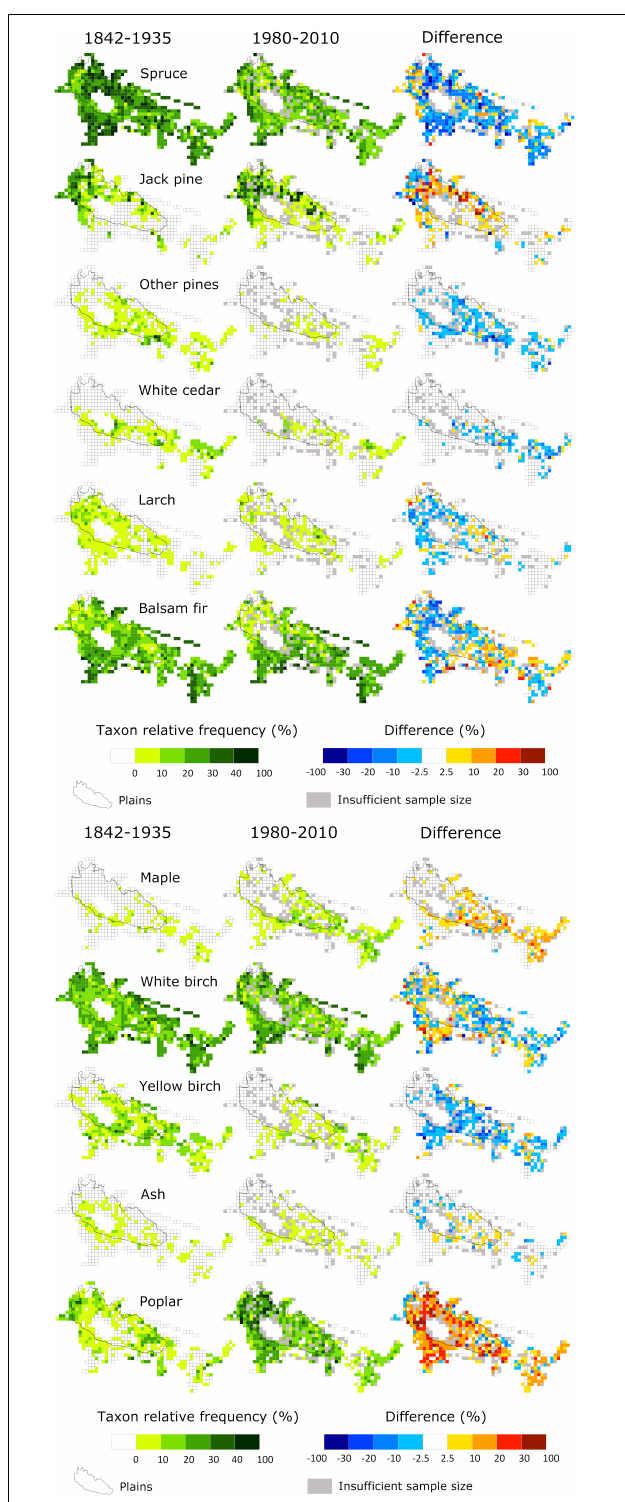
FIGURE 3 | Maps of taxa relative frequency aggregated to 25-km 2 grid cells for pre-settlement (1842–1935) and modern (1980–2010) periods. The difference is calculated by subtracting the relative frequency of the two periods (modern minus